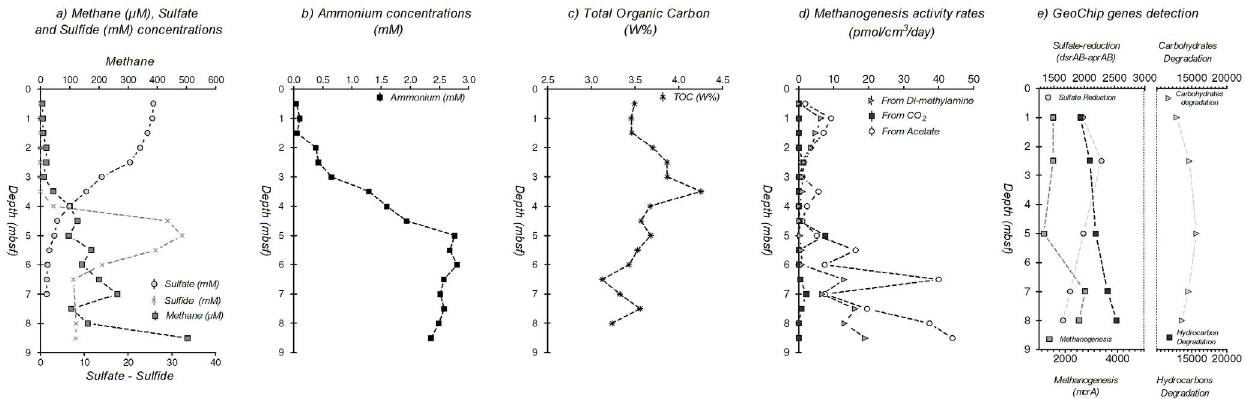
Figure 1. Geochemical depth profiles, putative methanogenesis activity rates and GeoChip genes detection of the sediment core BCK1. 1a) Dissolved methane (grey square, m M), sulfate (white circle, mM) and sulfide (grey cross, mM) concentrations in pore waters. 1b) Dissolved ammonium concentrations (mM) in pore waters. 1c) Total organic carbon (TOC) content in the sediments (% w/w). 1d) Methanogenesis activity rates from acetate (white circle), bicarbonate (black square) and di-methylamine (grey triangle) in the sediments (pmol/cm 3 /day). 1e) Relative signal intensity of the GeoChip microarray for sulfate-reduction (circle), methanogenesis (grey square), carbohydrates degradation (triangle) and hydrocarbon degradation (black square) pathways, normalized by the number of the probes for each indicated metabolic pathway.